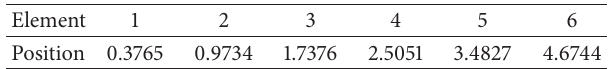
Table 6: Geometry of 12-element LAA (with respect to 𝜆/2) obtained using EFPA.